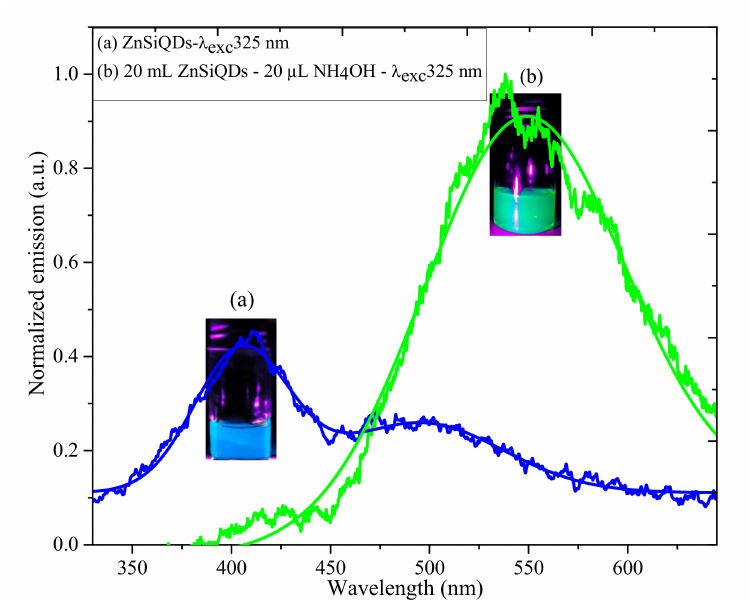
Figure 10. PL spectra (excited at 325 nm) of the colloidal ZnSiQD suspension in acetone synthesized ( a ) without and ( b ) with NH 4 OH (20 µ L). The bottles in the inset show the corresponding blue and green visible fluorescence observed by the naked eyes.